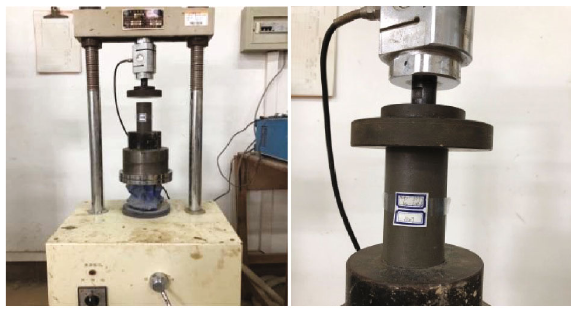
Figure 5: Determination of compressive